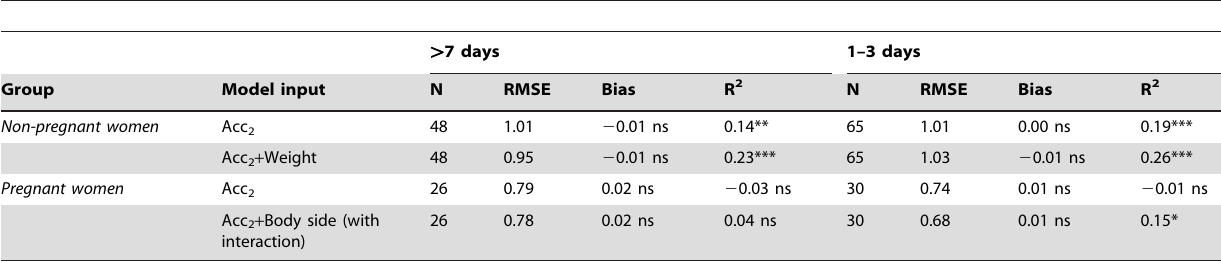
Table 4. Cross-validation using the leave-one-out method of regression models in which PAEE (MJ day 2 1 ) is the dependent